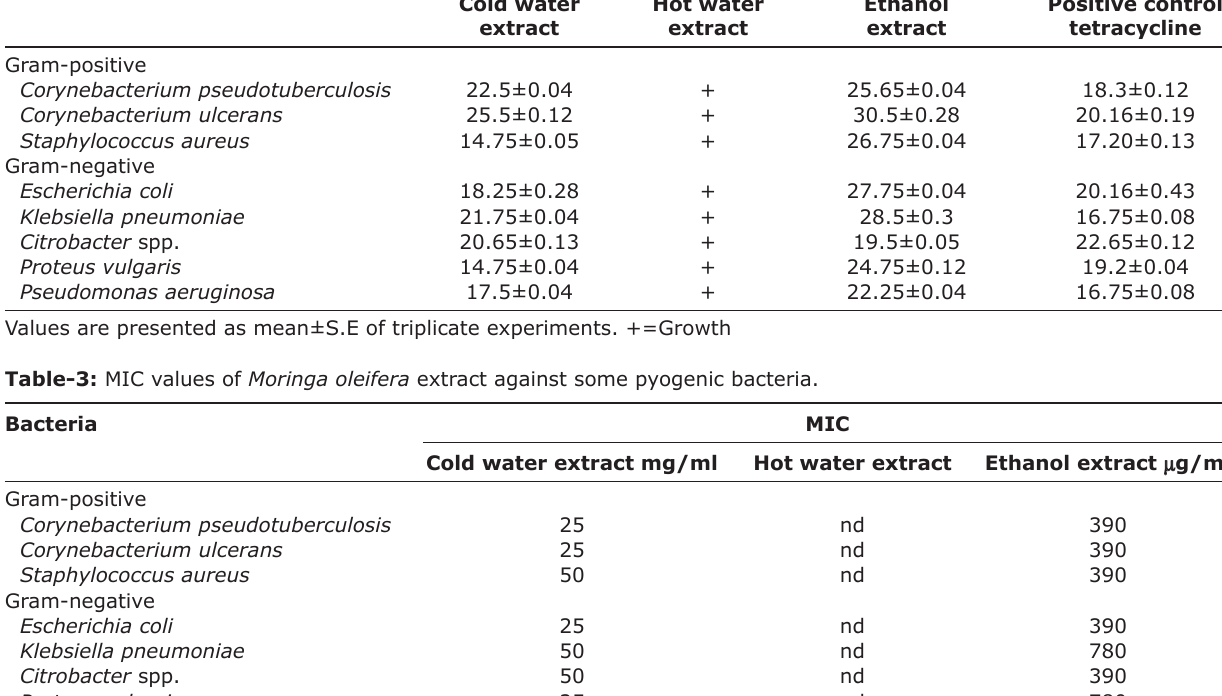
Table-2: Antibacterial activity of Moringa oleifera extracts against some pyogenic bacteria. Bacteria